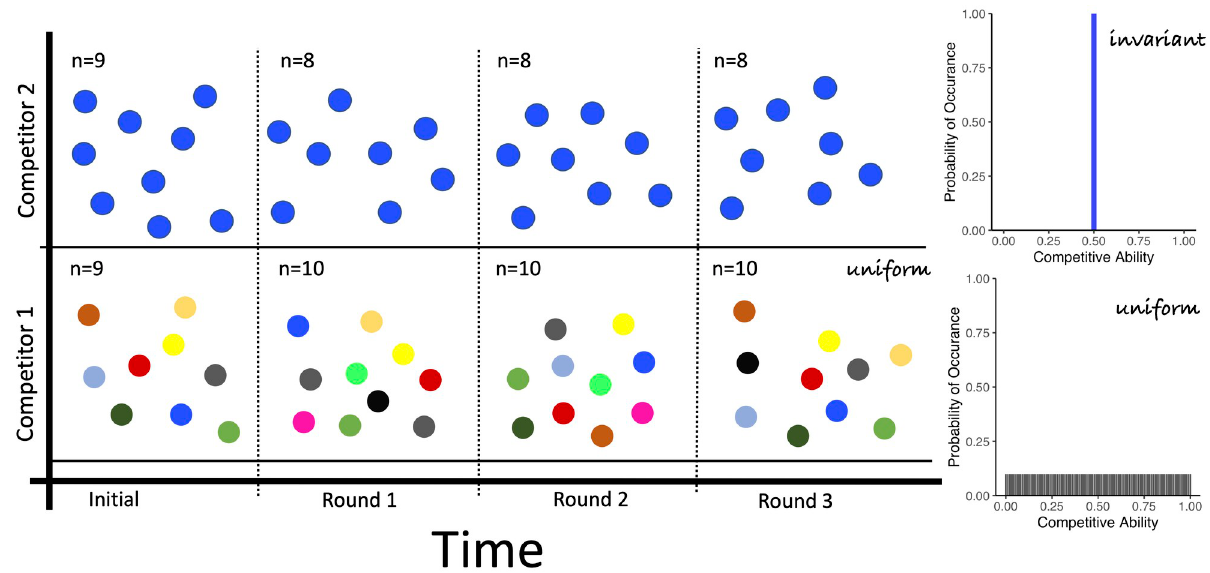
Fig 6. Phenotypically heterogeneous strategies enable co-existence. An equilibrium strategy also co-exists with the invariant strategy and in general co-exists with all strategies that have the same mean competitive ability.